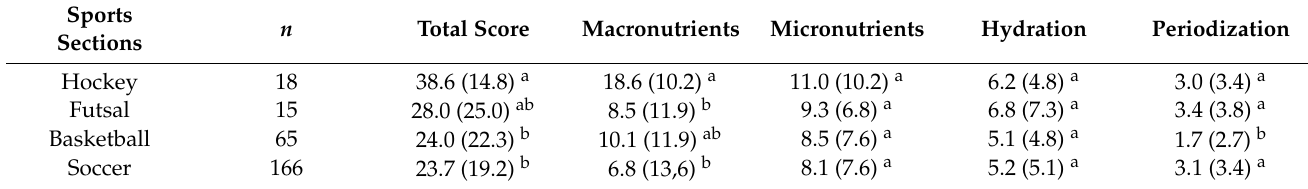
Table 3. Medians (interquartile range) of the NUKYA total and partial scores for the questionnaire subsections in FCB athletes ( N = 264). Different superscript letters indicate statistically significant differences ( p <